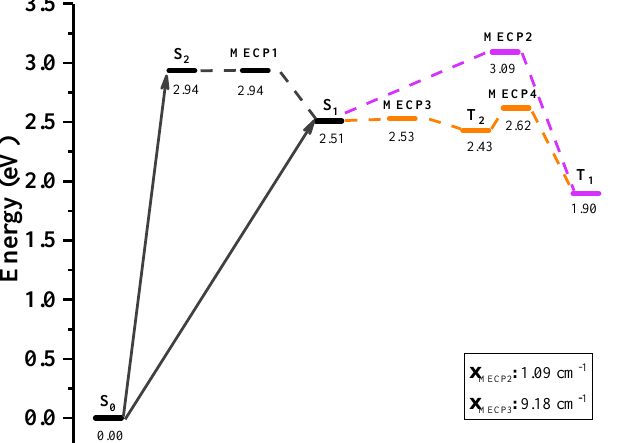
Figure 2. Energies of S-BF2 at the ground and exited states as well as the minimum energy crossing points (MECPs). ξ MECP represents the SOC constant at